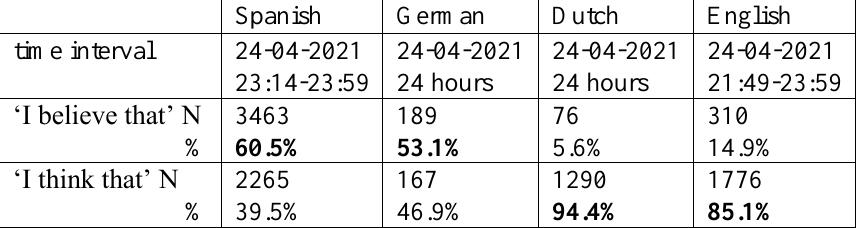
Table 1 : Numbers and percentages of creo que and pienso que and its counterparts in German, Dutch, and English in a Twitter corpus, with the highest percentage per language in